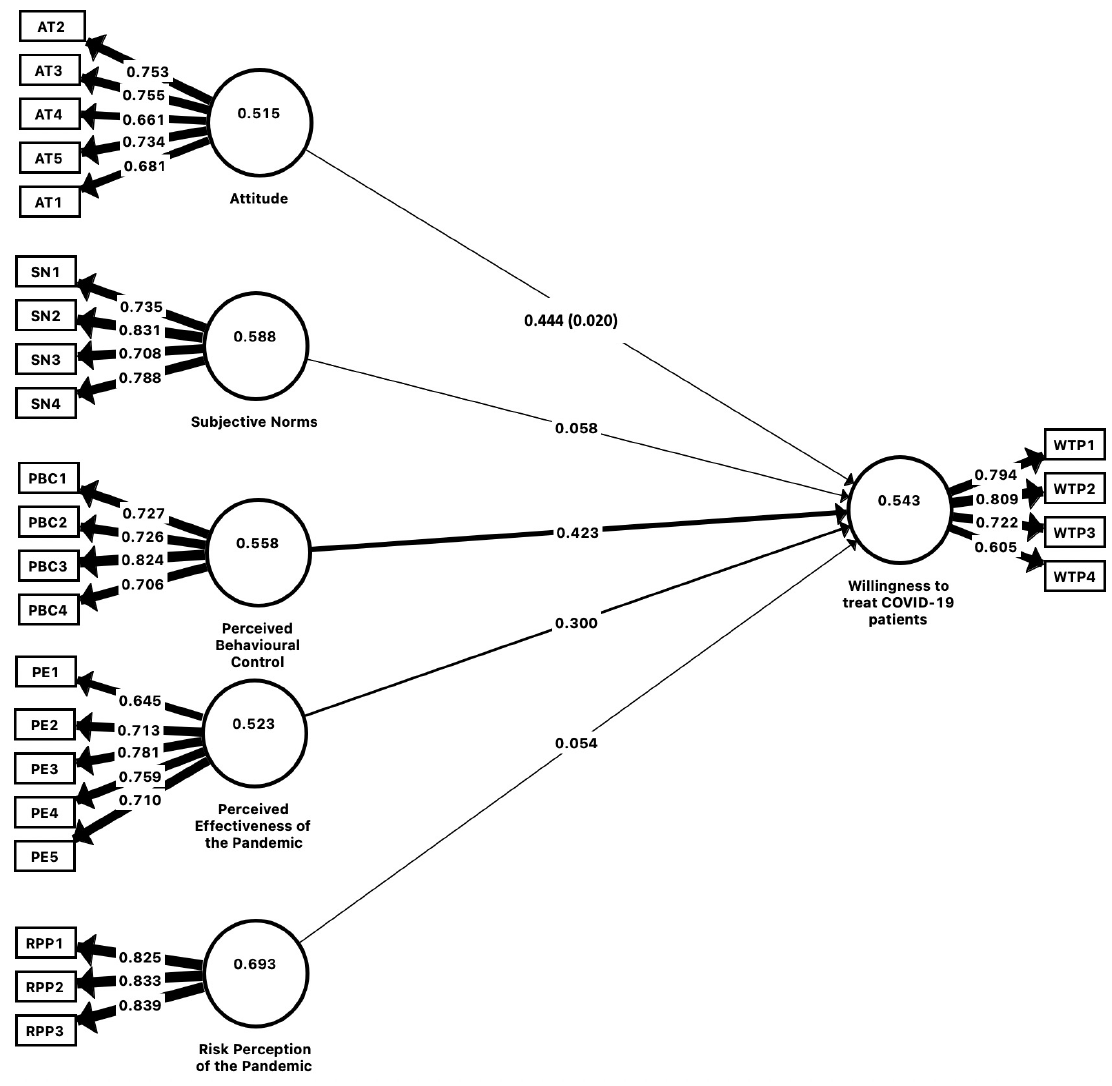
Figure 1. Structural